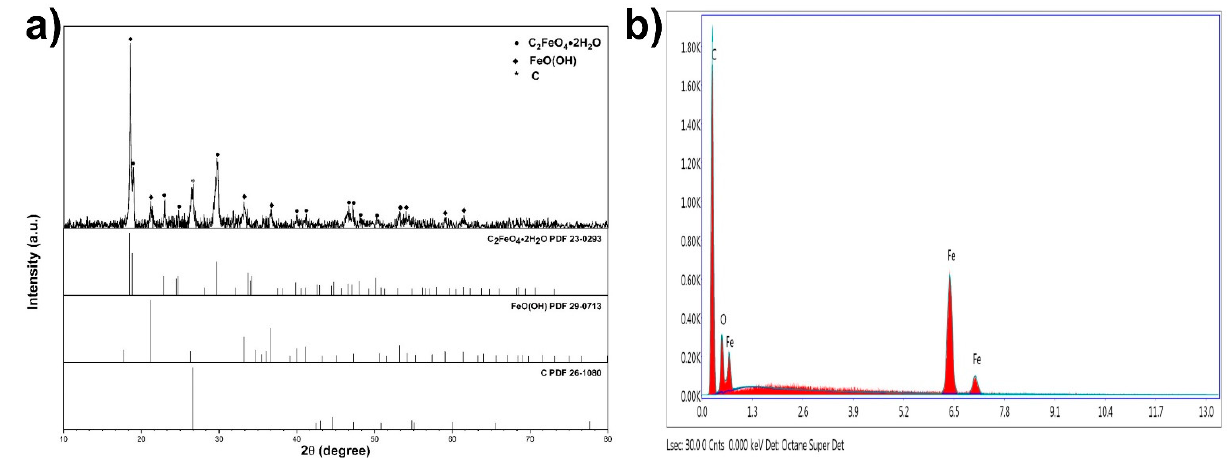
Figure 2. ( a ) SEM image of OPFCNT fiber; ( b ) SEM image of FeC 2 O 4 + FeOOH coated OPFCNT fiber; ( c ) Higher magnification image of ( a ); ( d ) Higher magnification image of ( b ).